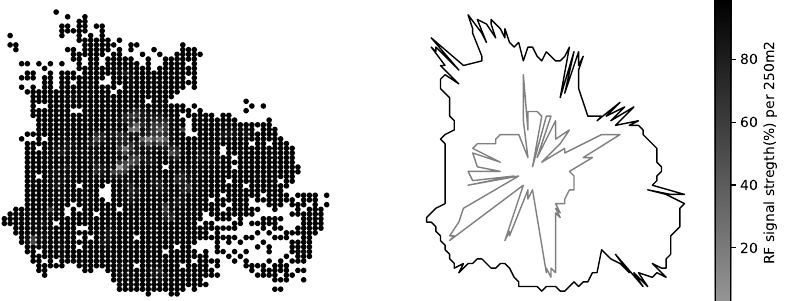
Figure 11. Cell coverage area represented by a raster map ( left one ) and a 2-level polygon ( right one ). Polygonal model provides only brief RF signal strength distribution within the cell